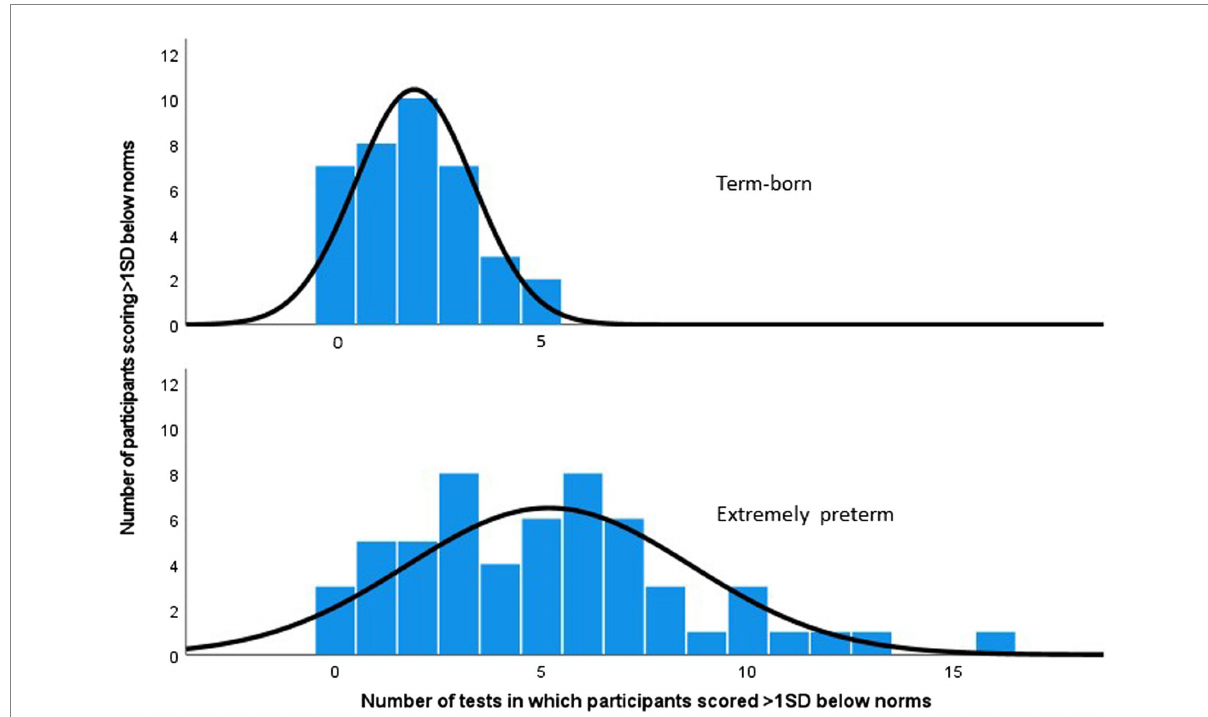
FIGURE 2 Number of children versus the number of subtests in which 56 extremely preterm and 37 term-born children performed over one standard deviation (SD) below test norms in 20 domains of four assessments. Likelihood Ratio (df) 37.09 (14), p <